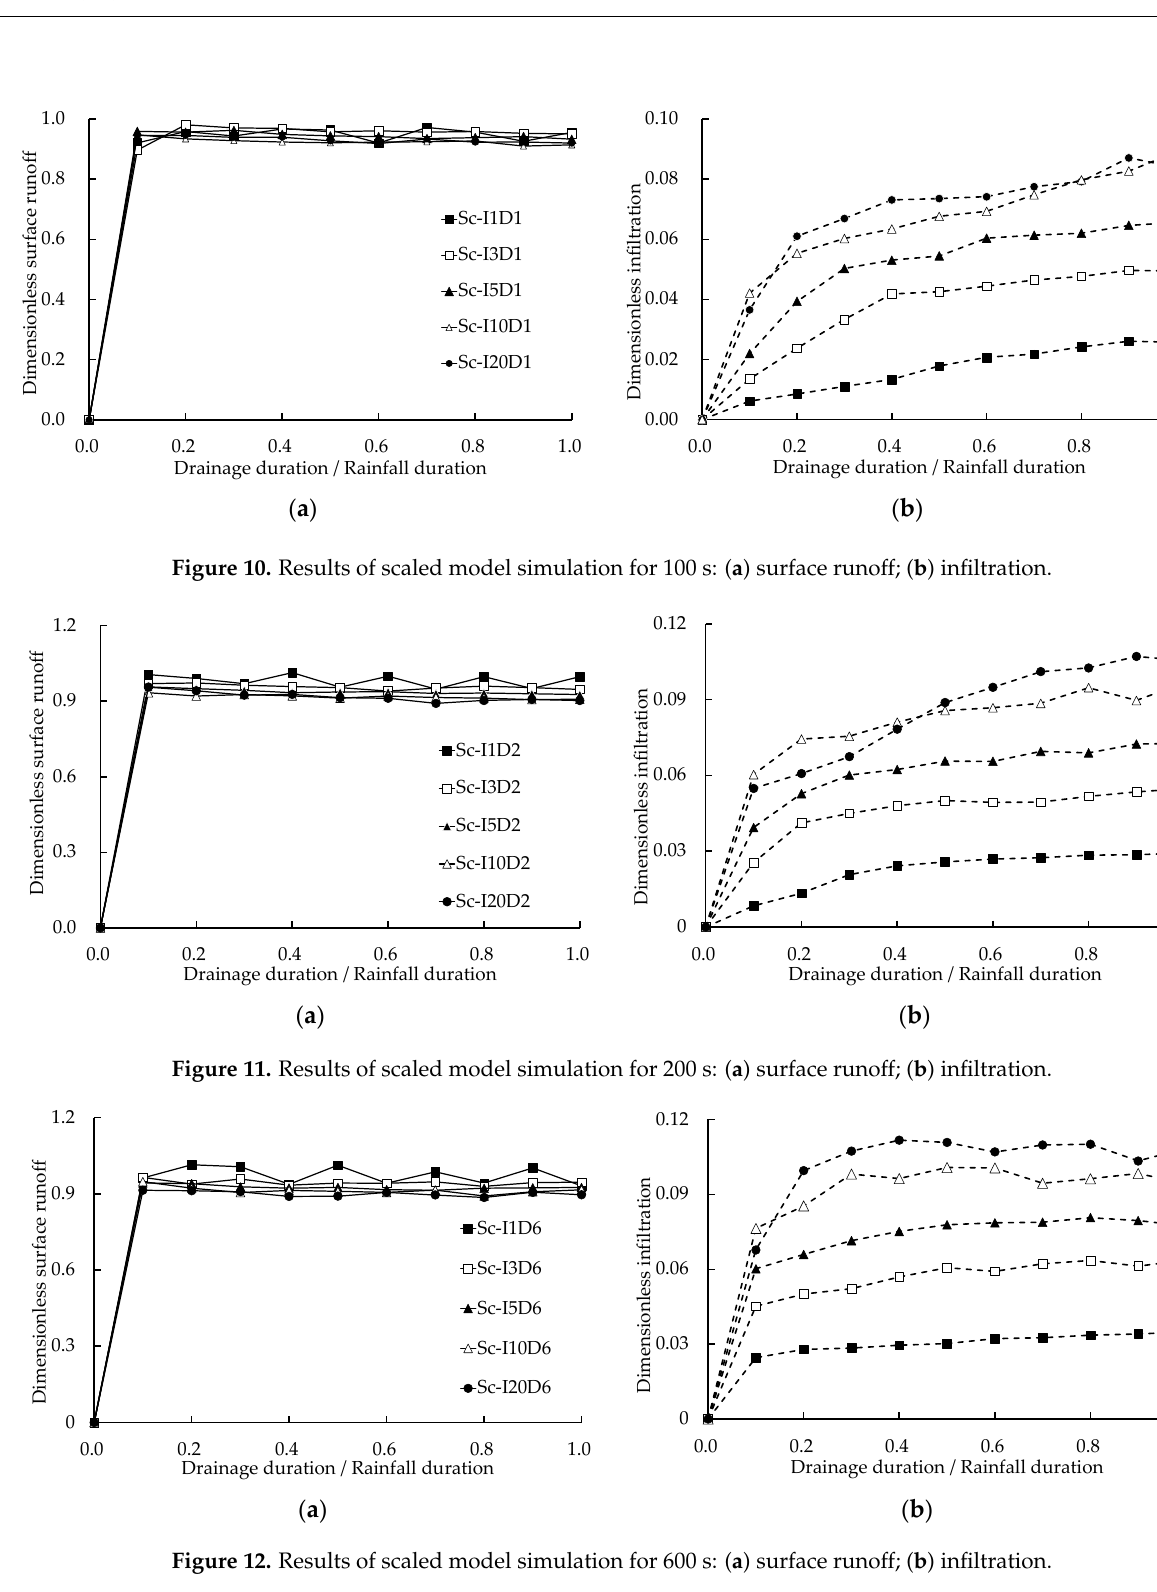
( b ) Figure 13. Scaled model simulation with rainfall depth 2.78 mm: ( a ) dimensionless surface runoff; ( b ) dimensionless infil- tration. ( b ) Figure 14. Scaled model simulation with rainfall depth 5.56 mm: ( a ) dimensionless surface runoff; ( b ) dimensionless infil- tration.